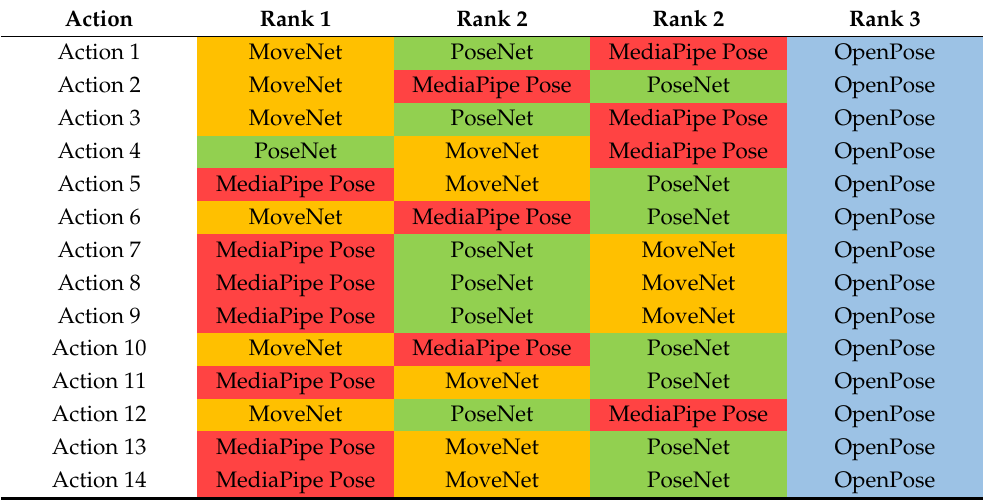
Table 7. Overall average of PDJ (%) in each action.